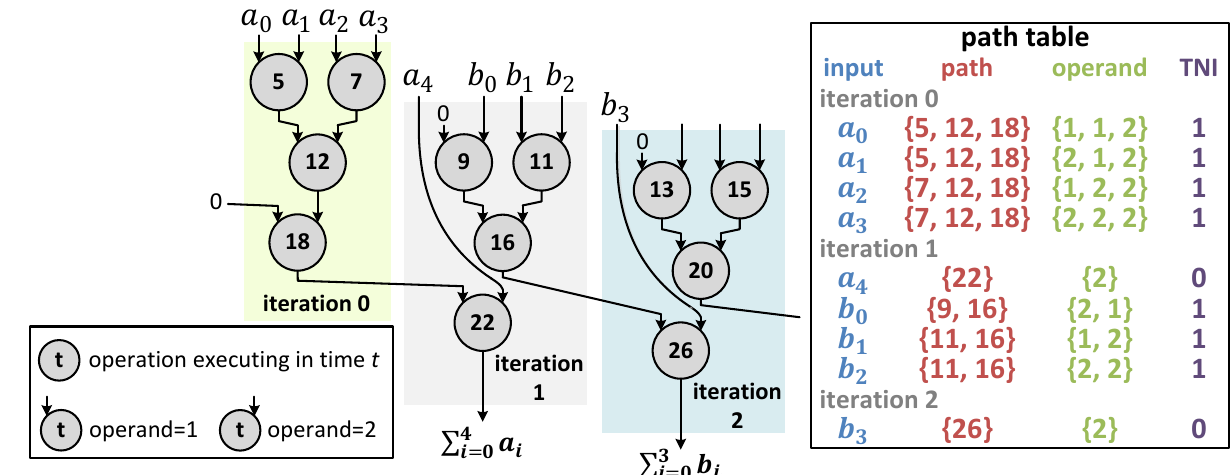
a i and ∑ 3 b i needs to be i = 0 i = 0